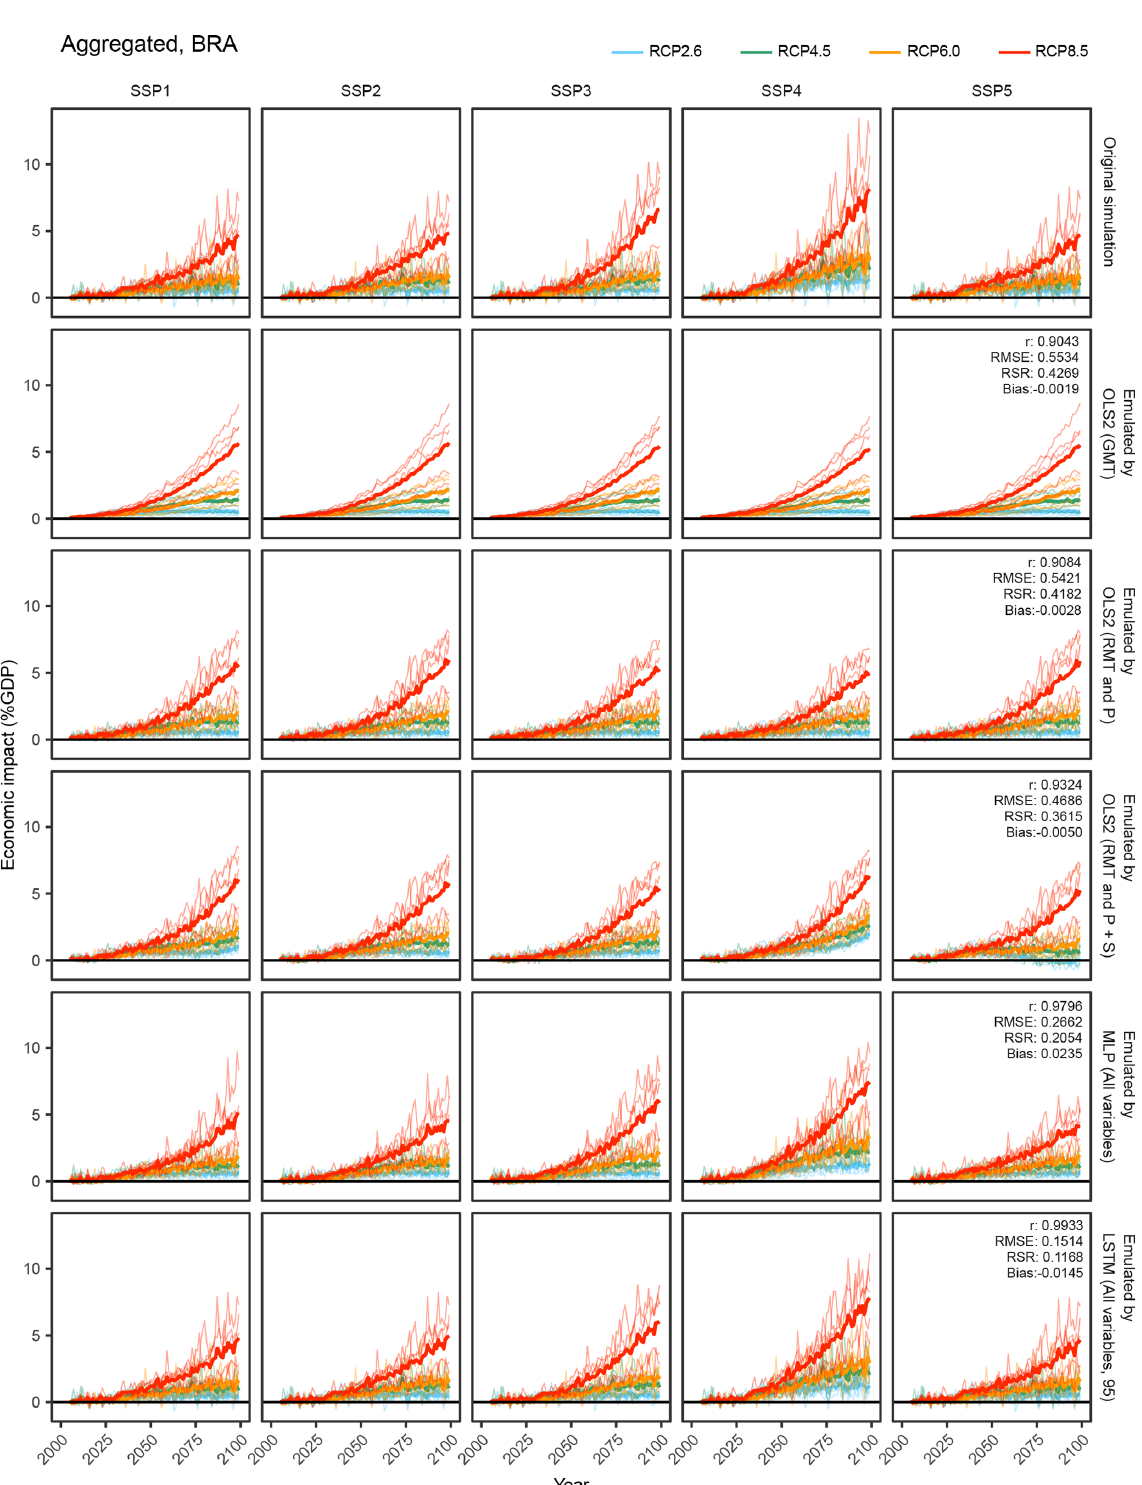
Figure 8. Time-series results of the simulation and emulations for aggregated economic impacts in the Brazil region. OLS2 (GMT): OLS2 with global mean temperature. OLS2 (RMT and P): OLS2 with regional mean temperature and precipitation. OLS2 (RMT and P + S): OLS2 with regional mean temperature precipitation and socioeconomic variables. MLP (All variables): MLP with all the input variables. LSTM (All variables, 95): LSTM with all the input variables for 95 years. Thin lines represent individual GCM results, and bold lines represent average of five